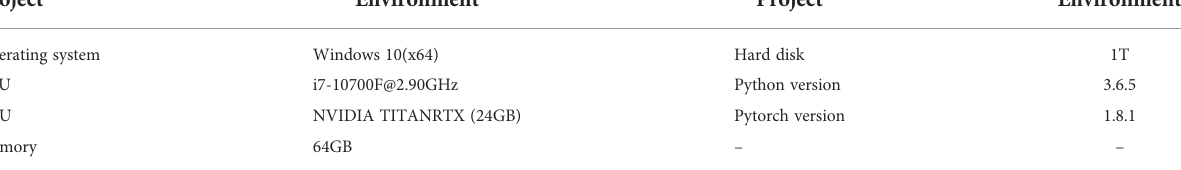
TABLE 3 Experimental